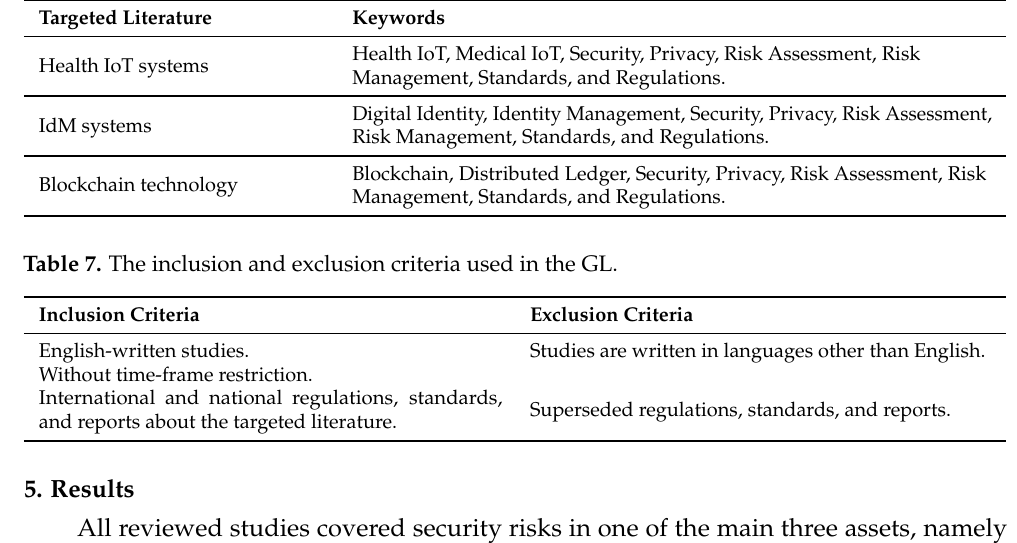
Table 6. The keywords and inclusion and exclusion criteria used in the search process for GL. Targeted Literature